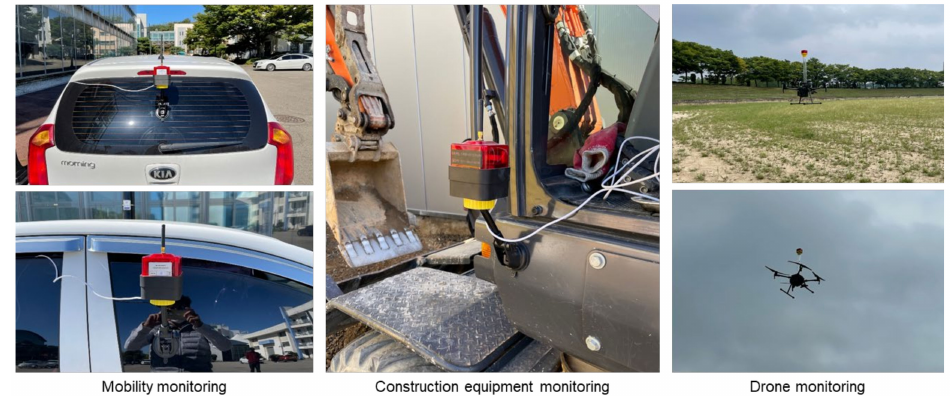
Figure 2. Mobile installation of